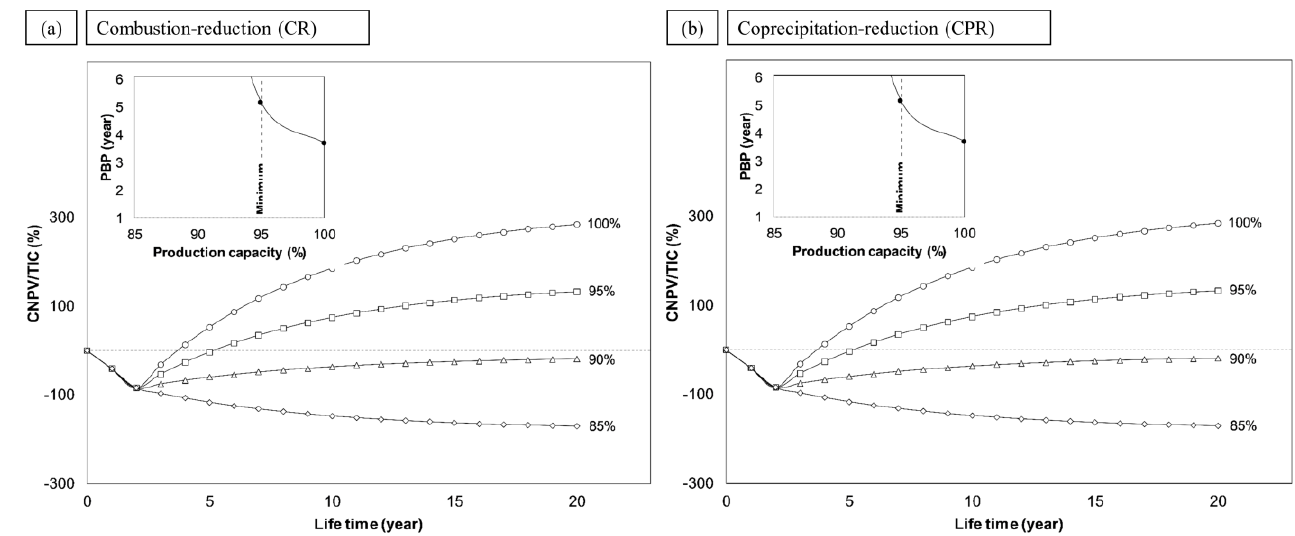
Fig. 12. CNPV/TIC curves in accordance to life time for (a) combustion-reduction (CR) and (b) coprecipitation-reduction (CPR) under various production capacities. An insert image is the analysis of PBP based on production capacities.